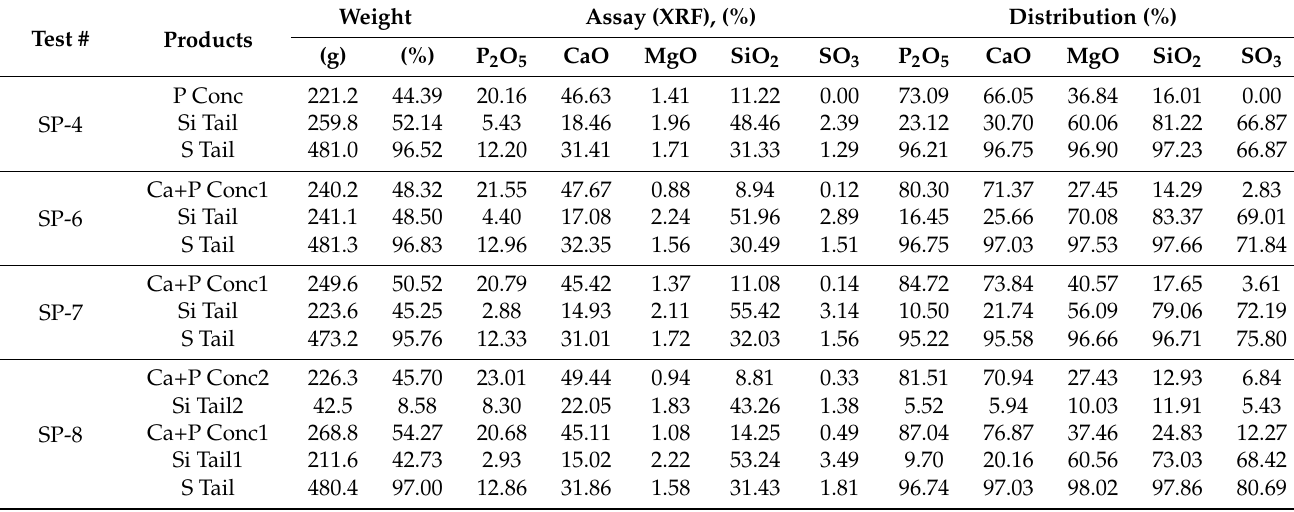
Table 5. The results of direct phosphate